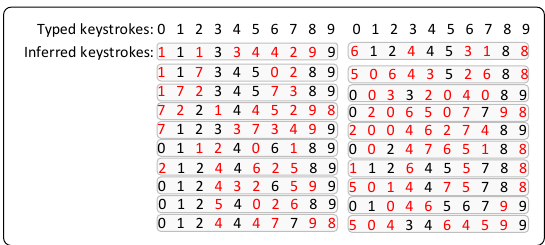
Figure 14. Recognition accuracy of keystrokes when there exists channel interference.